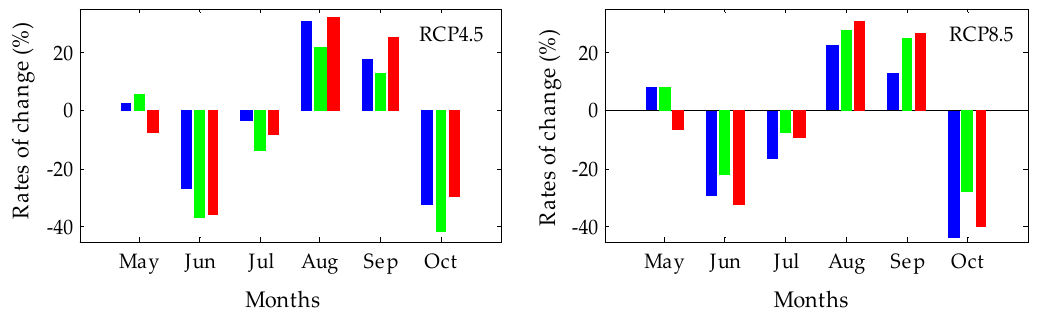
Figure 4. Rates of change of monthly rainfall amounts per projected period and scenario (blue: P1, green: P2 and red: P3).